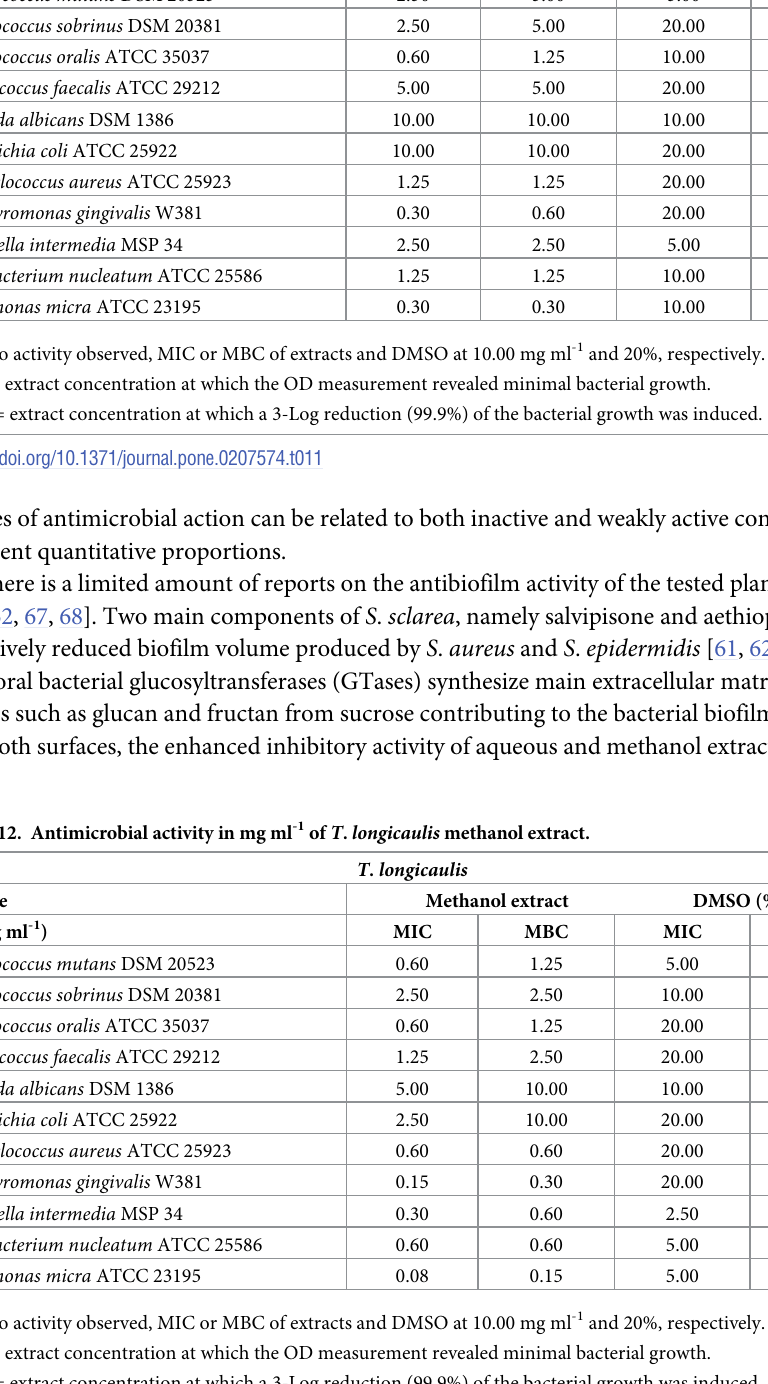
Table 11. Antimicrobial activity in mg ml -1 of O . vulgare methanol extract. Sample